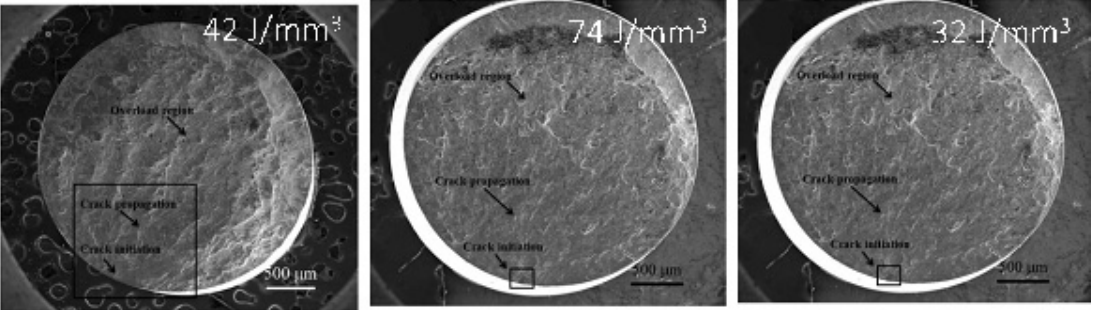
Figure 11. Fracture surfaces of Ti6Al4V by LPBF using different processing conditions correspond- ing to energy densities of 42, 74 and 32 J/mm 3 (adapted with permission from [69]. Copyright 2015 Elsevier).